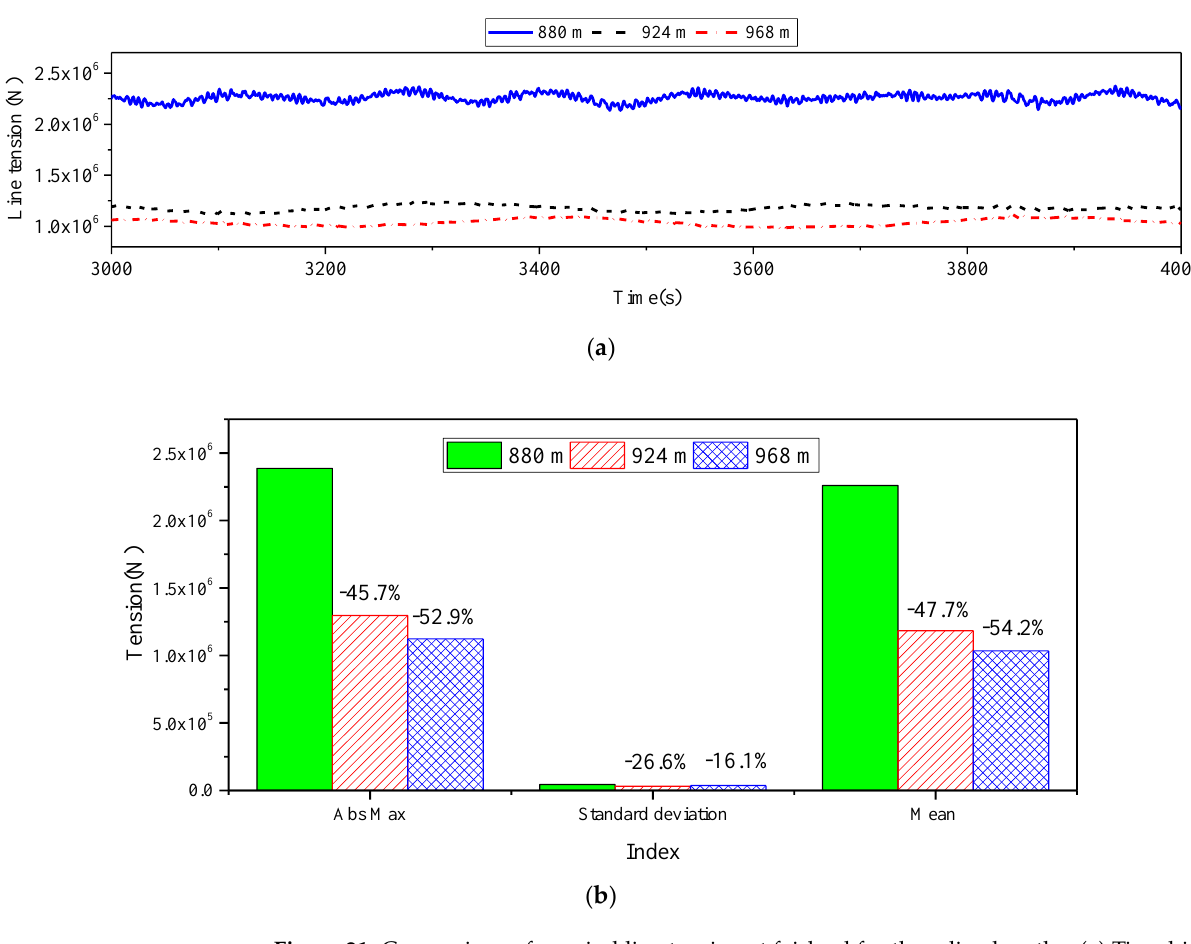
Figure 21. Comparison of upwind line tension at fairlead for three line lengths. ( a ) Time histories. ( b ) Statistics.